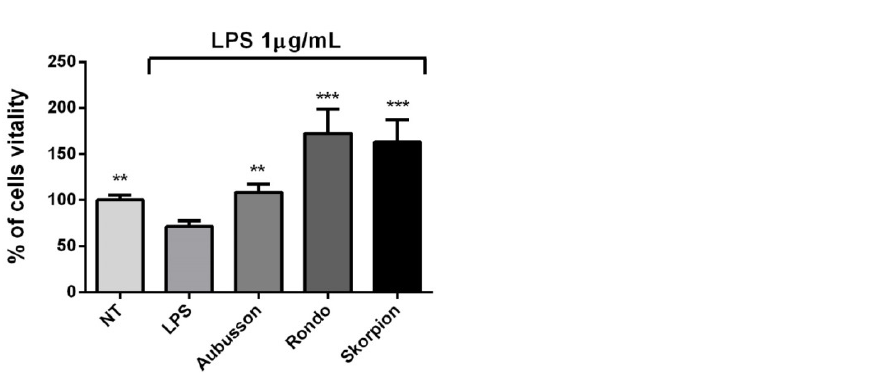
Figure 4. Recovery of cell viability. RAW 264.7 cells were incubated with LMW peptides (0.05 mg/mL) from the breads for 1 h and then with LPS for 24 h. Cell viability was evaluated using the crystal violet test. The absorbance due to viable cells was read at 595 nm. NT: negative control, untreated cells; LPS: positive control, cells treated with the only LPS; Aubusson, Rondo, and Skorpion indicate cells treated with both LPS and LMW peptides. Data reported in the figure represent the mean ( ± SD) of three different experiments performed in duplicate. Statistical analysis was performed for each sample vs. LPS. (** p < 0.01; *** p < 0.001) .